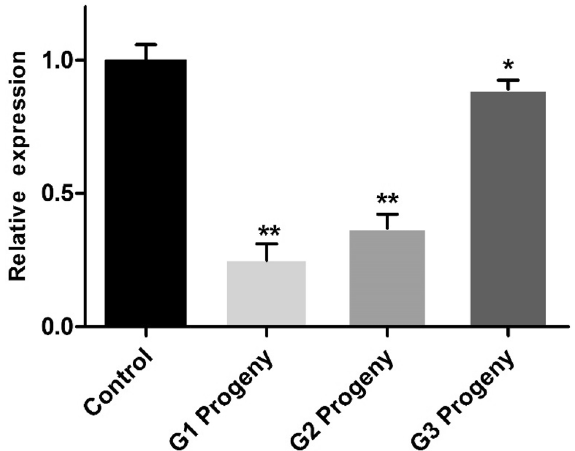
Figure 9. Changes in mRNA transcript level of CmGNA gene in G1–G3 generations after pRNAi. Each bar indicated the mean ± SD , and significant differences indicated by *(P < 0.05), **(P <